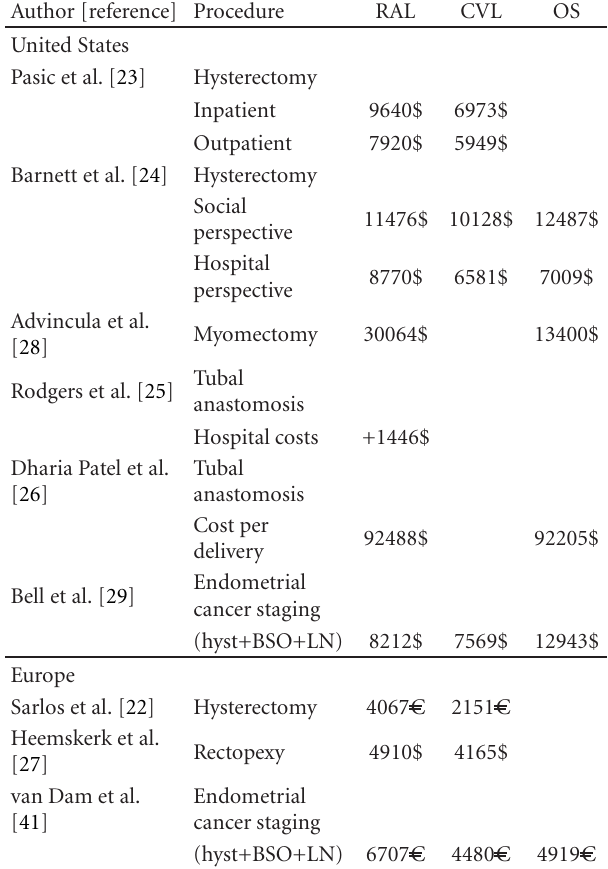
Table 1: Cost analysis of gynecologic surgical procedures per- formed by robot-assisted laparoscopy (RAL), classic video-laparo- scopy (CVL), and open surgery (OS). Total hospital costs are given unless specified di ff